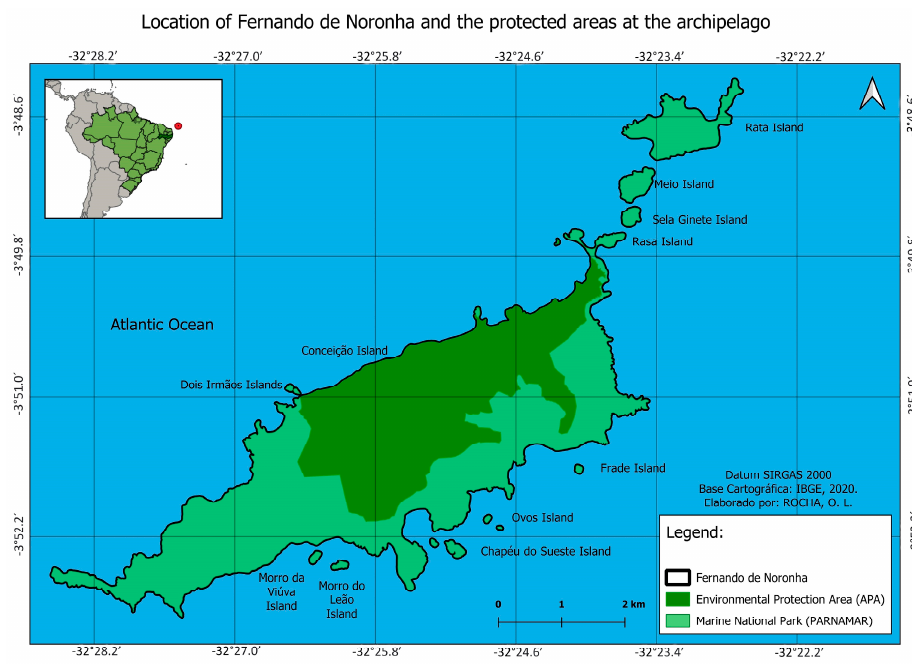
Figure 1. Location of Fernando de Noronha archipelago and the protected areas at the Archipelago, the National Marine Park (in light green), and the Environmental Protected Area (in green).